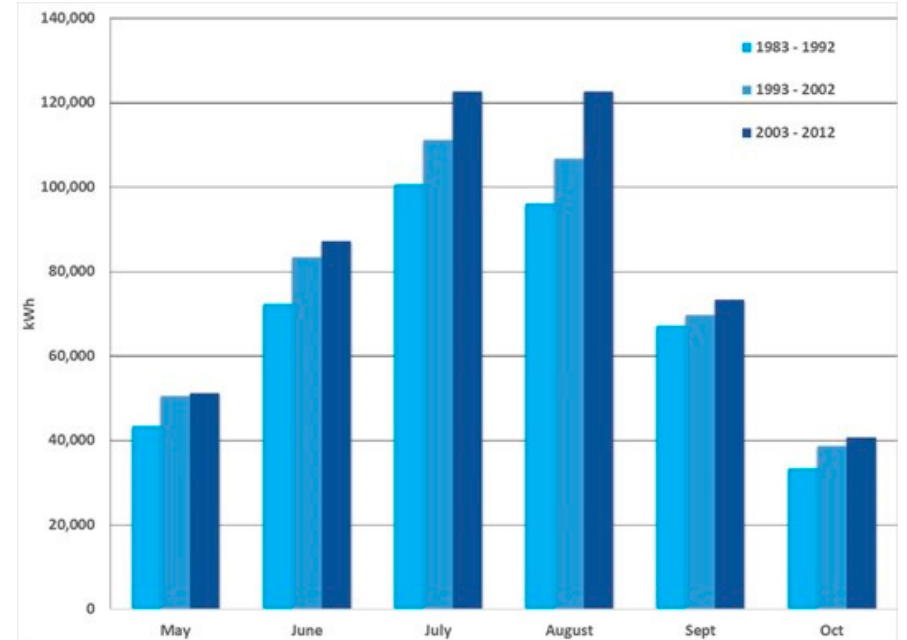
Energies 2021 , 14 , x FOR PEER REVIEW Figure 10. Total (sensible and latent) monthly energy requirements for cooling.